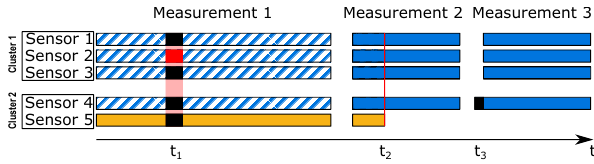
Figure 2. Illustration of data fusion with five sensors from two dif- ferent sources (cluster 1/2). If one sensor sends faulty or noisy data over some time (sensor 2 at t 1 ), DAV 3 E will automatically ignore all data during that time in the fused dataset. If a sensor fails (sen- sor 5 at t 2 ), the user can choose to have more observations, but with- out that sensor (blue data), or to include all sensors, but with fewer observations (orange data). If a sensor starts too early (sensor 4 at t 3 ), its data will be ignored until data from all sensors are available. Such events can either be annotated by the user or imported directly from the test setup if the data are